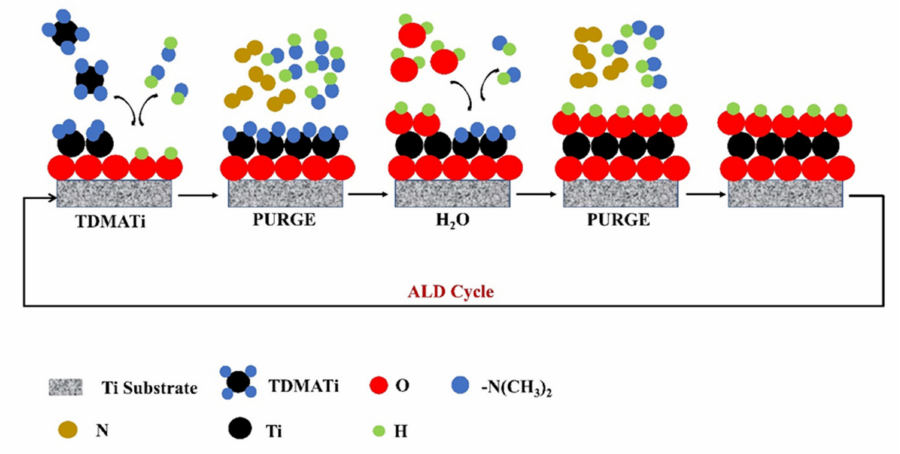
Figure 5. Scheme showing the preparation of TiO 2 thin films using ALD. TDMATi reacts with the –OH terminated surface of the Ti substrates (with TiO 2 superficial), leaving a methyl terminated surface. N 2 subsequently cleans the surface of compounds not adhering to the substrate. Water later reacts with the methyl groups, creating a surface with –OH groups. Next, N 2 cleans the surface again. This process is repeated over several cycles to obtain a film with the desired